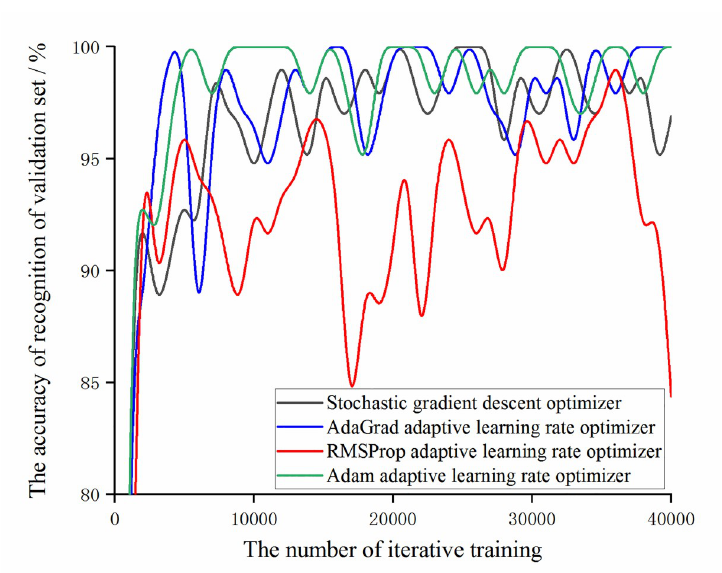
Fig 14. The trend of the accuracy of the validation set with the number of iterative training under different optimizers.